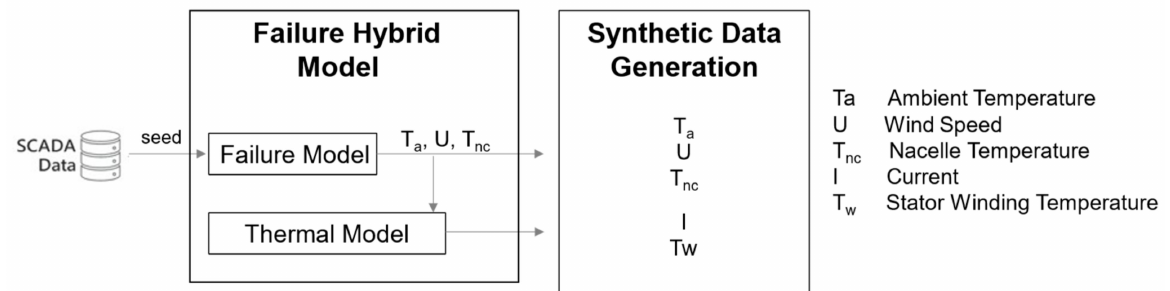
Figure 15. Generation of random patterns (in grey) of wind speed based on real SCADA data (in red). The DT generates the rest of failure synthetic measurements (e.g., stator winding tem- perature, and generator output current,) creating a multivariate synthetic failure scenario (Figure 16).